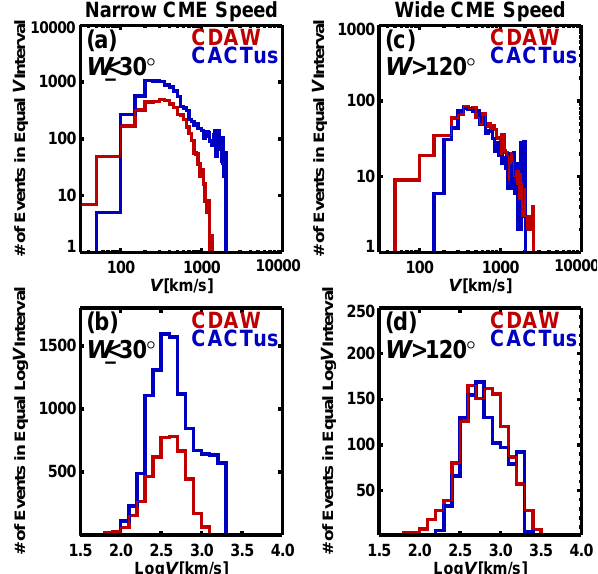
Fig. 3. Speed Distributions of narrow ( W< 30; left) and wide ( W> 120) CMEs. In the same way as Fig. 1, the number of events in each bin is counted by equal intervals on a linear scale (top) and on a log scale (bottom).